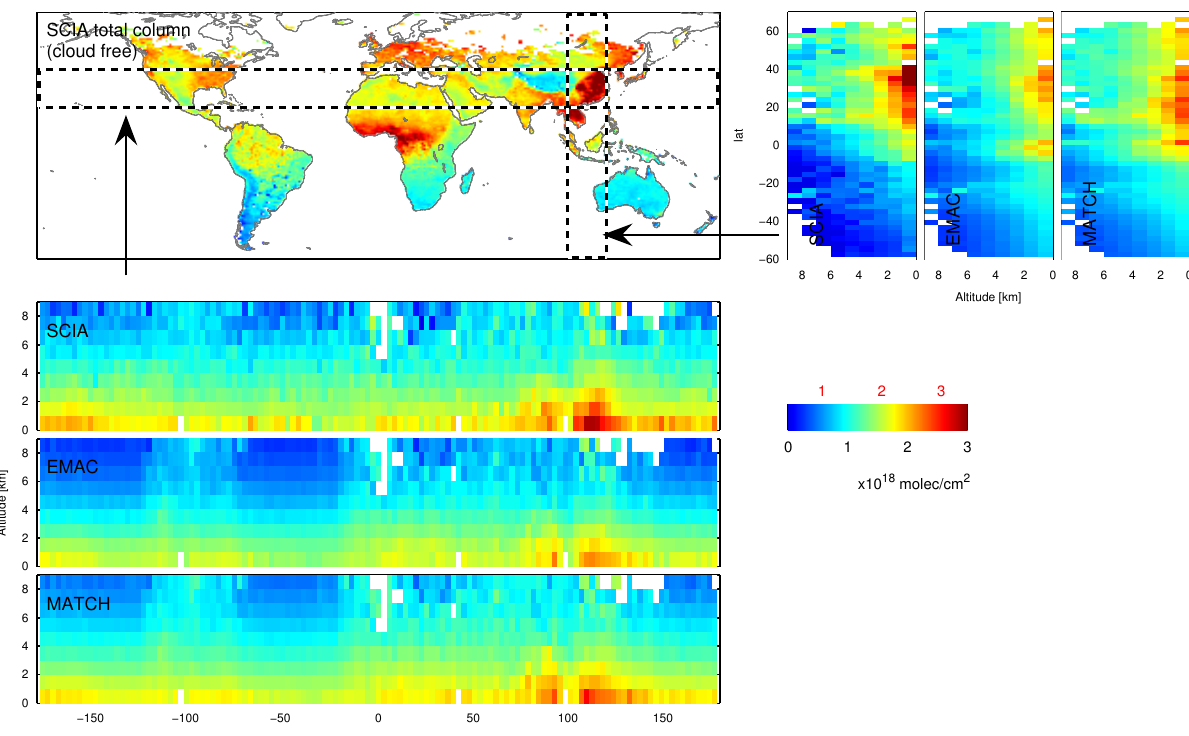
Fig. 11. Top left: global distribution of the total CO VCD for January–March derived from mainly clear-sky SCIAMACHY observations (Liu et al., 2011). Top right: meridional cross sections of profiles of CO PVCDs (for CRF >30%) for the same season derived from SCIAMACHY observations and model simulations. Bottom: zonal cross sections of profiles of CO PVCDs for the same season derived from SCIAMACHY observations and model simulations. Note that the colour scale is different for satellite observations and models (SCIAMACHY: red numbers on top of colour bar; models: black numbers below colour